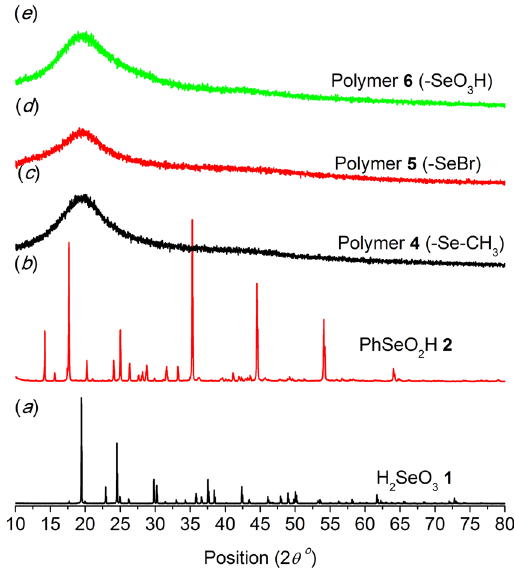
Figure 1. PXRD patterns: ( a ) H 2 SeO 3 1 ; ( b ) PhSeO 2 H 2 ; ( c–e ) Polymers 4 – 6 .